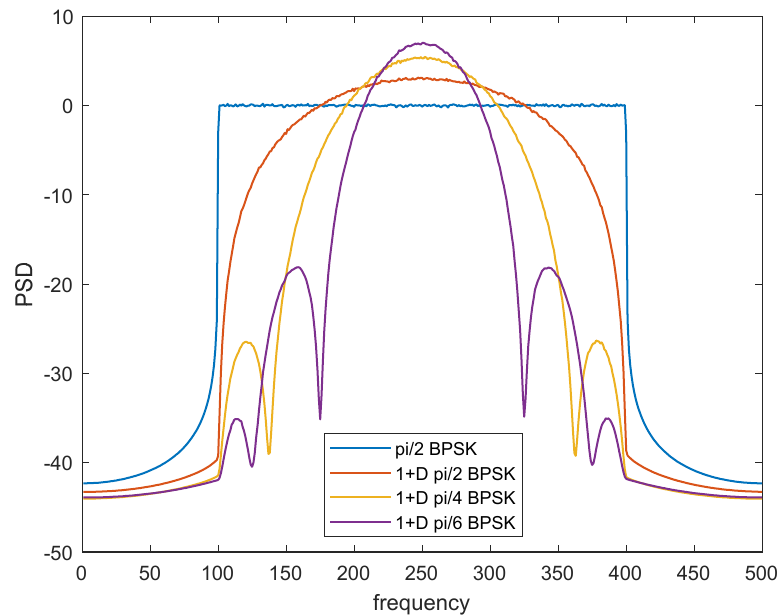
Figure 4. PSD comparison of three modulation schemes. Table 4. Simulation parameter.